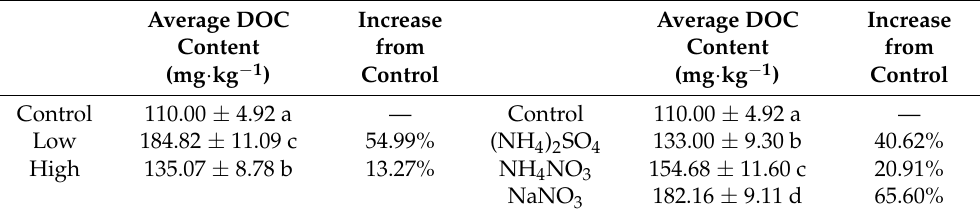
Table 3. Average DOC content in control and N addition plots.